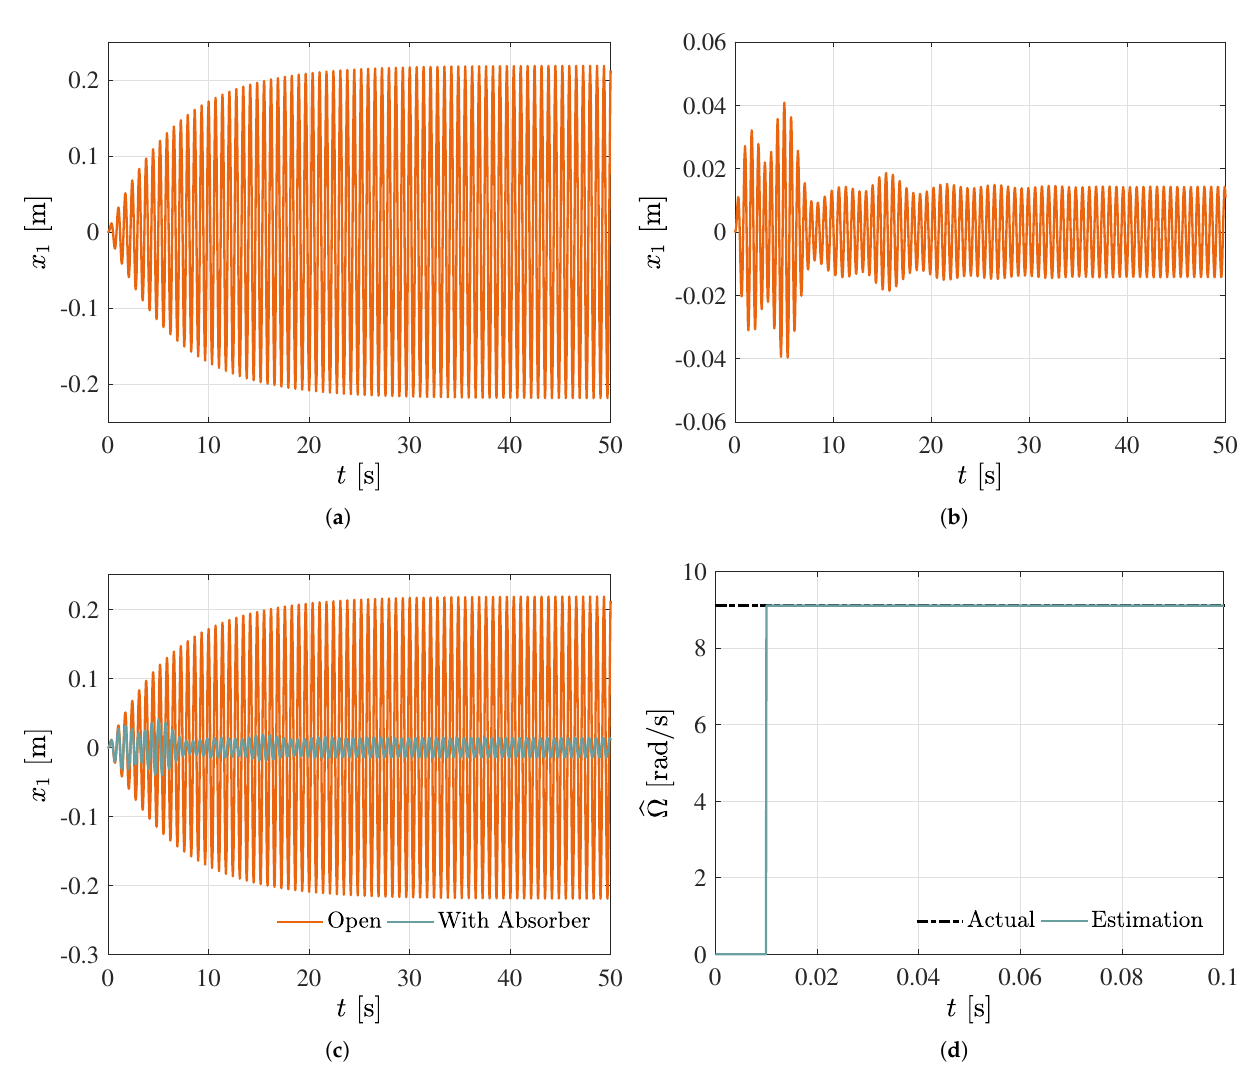
Figure 2. Effective frequency estimations using position measurements for the simulation case study. ( a ) Position the output response of the primary vibrating system without a dynamic vibration absorber; ( b ) position the output response of the primary vibrating system with a dynamic vibration absorber; ( c ) position the output responses of the primary system with and without a dynamic vibration absorber; ( d ) fast accurate estimation of the excitation